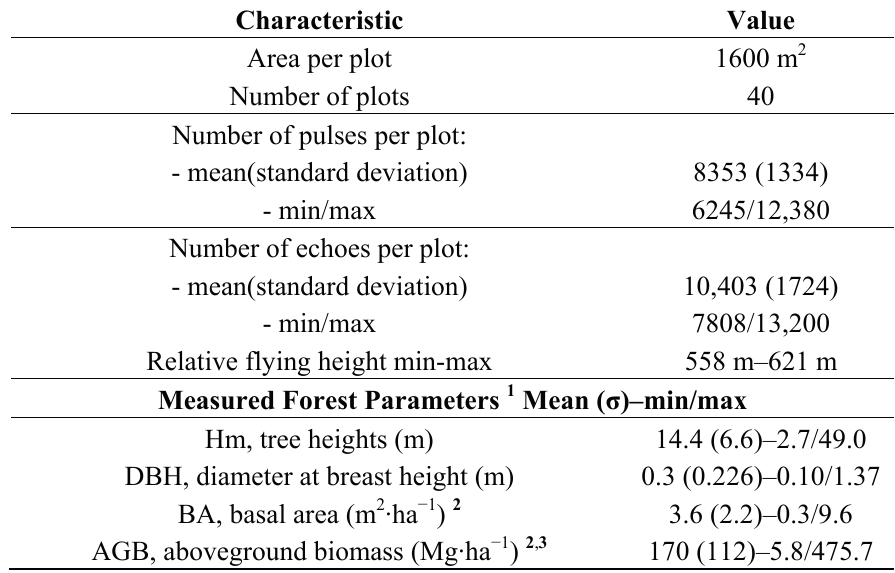
Table 1. Plot characteristics with the frequency distribution of the count of LiDAR